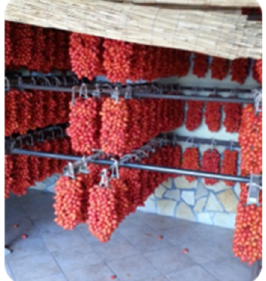
Figure 1. “Pomodorino del Piennolo”.